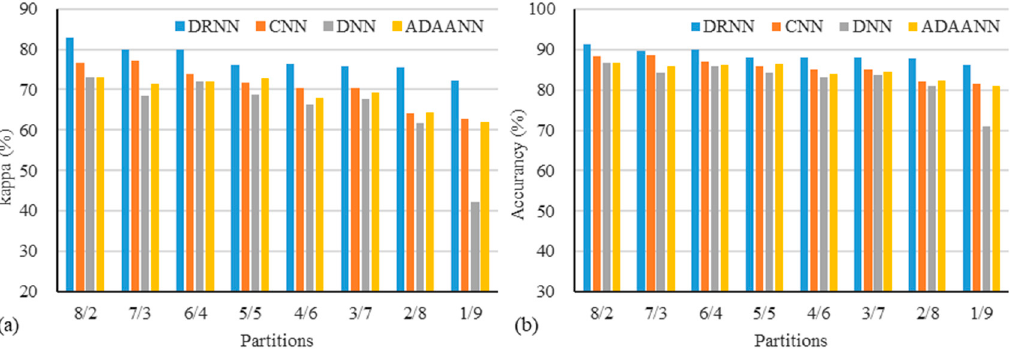
Figure 9. Robustness test on the training data size: ( a ) Changes in K values, ( b ) Changes in OA values.